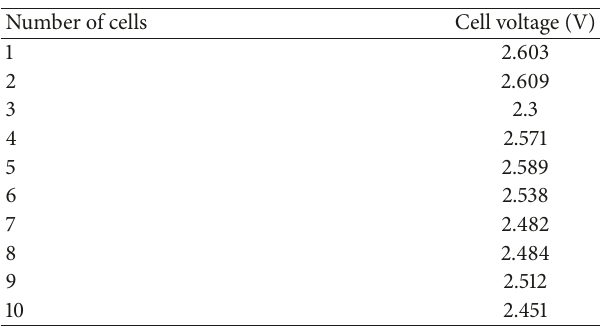
Table 3: Voltage cells